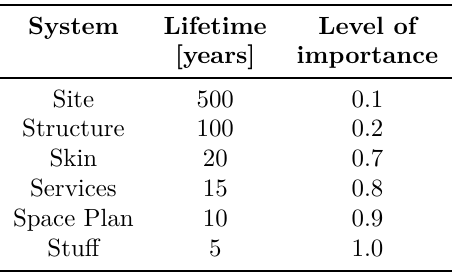
Table 1. Lifetime (Lsys) in years and level of im- portance of each system, based on the Brand’s six building layers